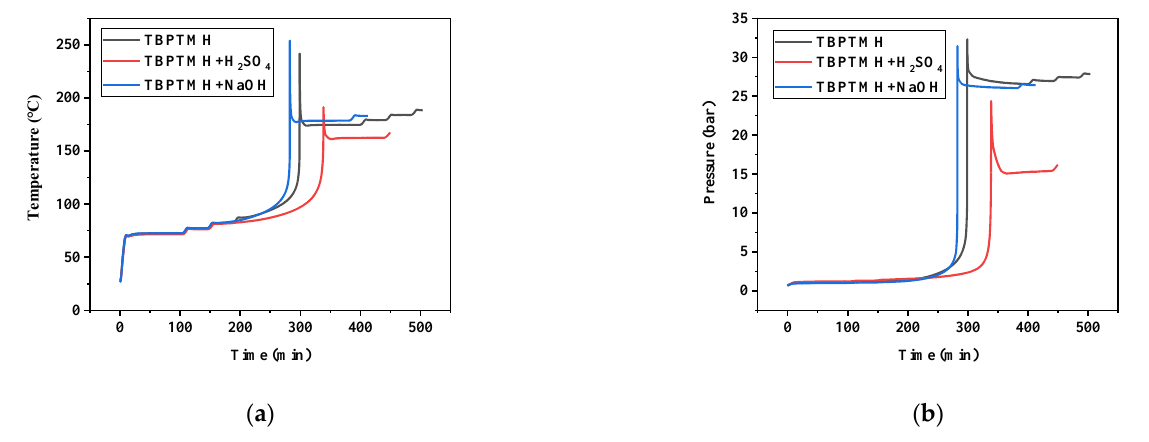
Figure 4. Temperature–time curve ( a ) and pressure–time curve ( b ).